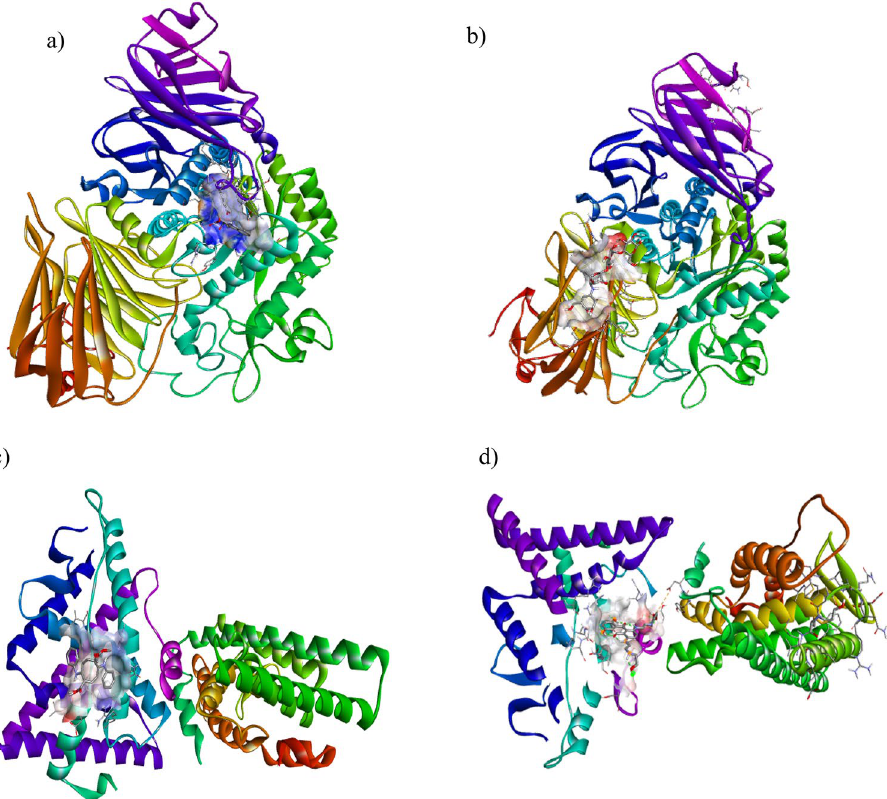
approved drug) caulerpin